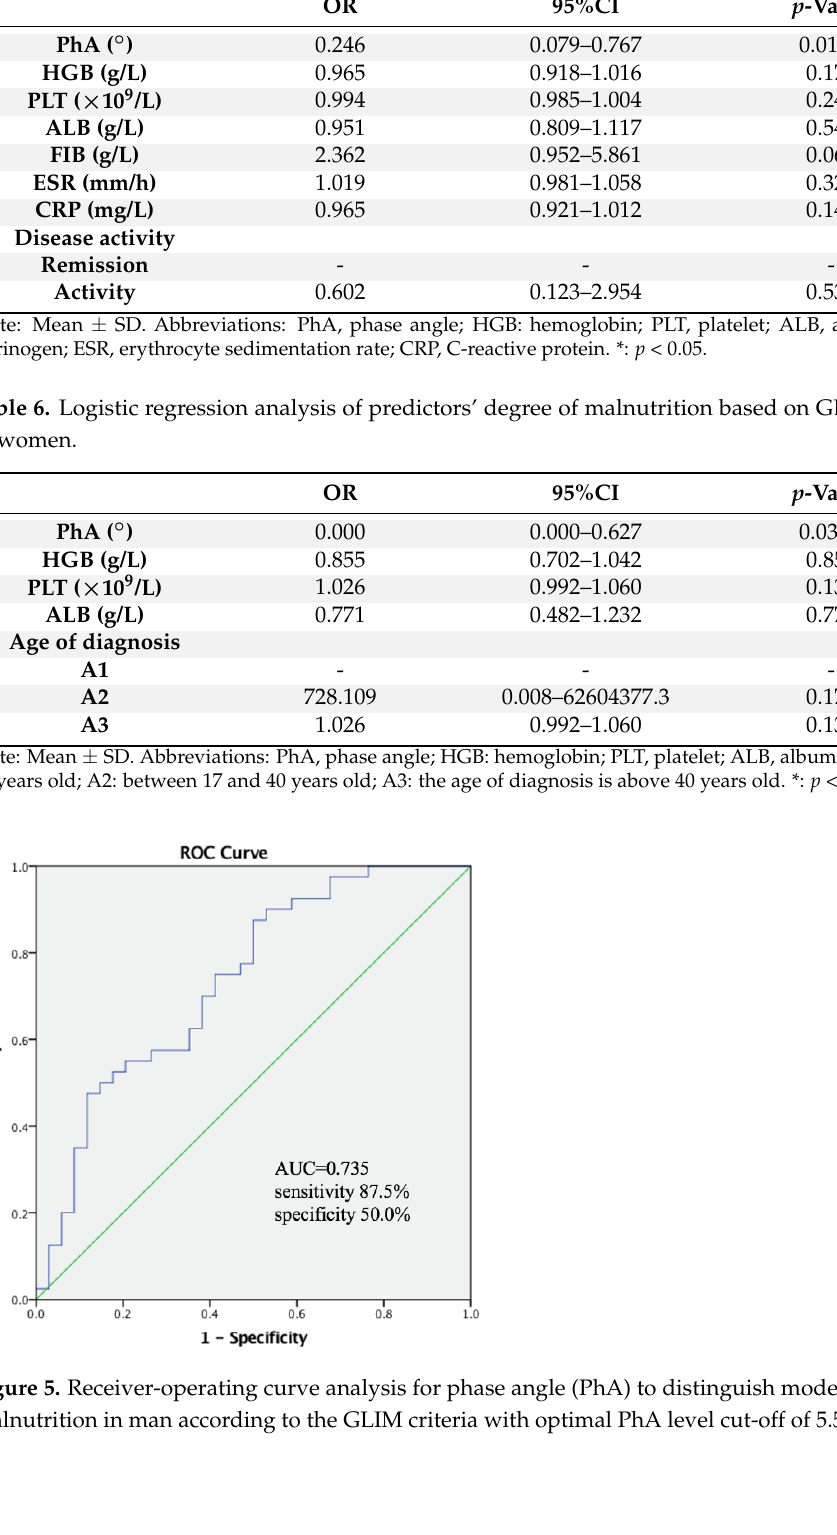
Table 5. Logistic regression analysis of predictors ’ degree of malnutrition based on GLIM criteria in men.